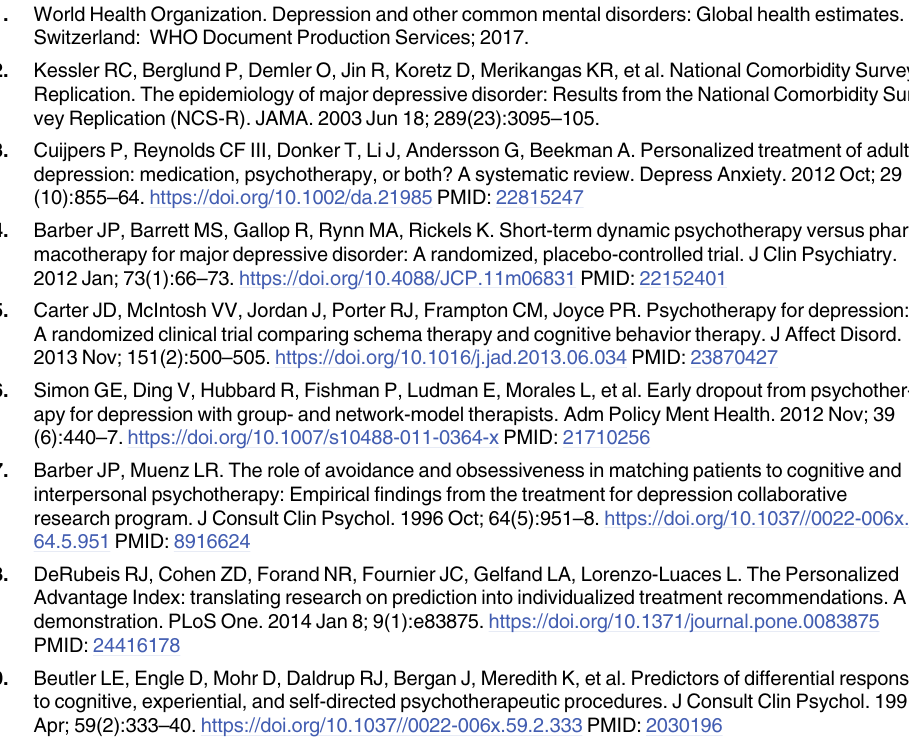
, R , S , and SI represent initial depressive 0 0 0